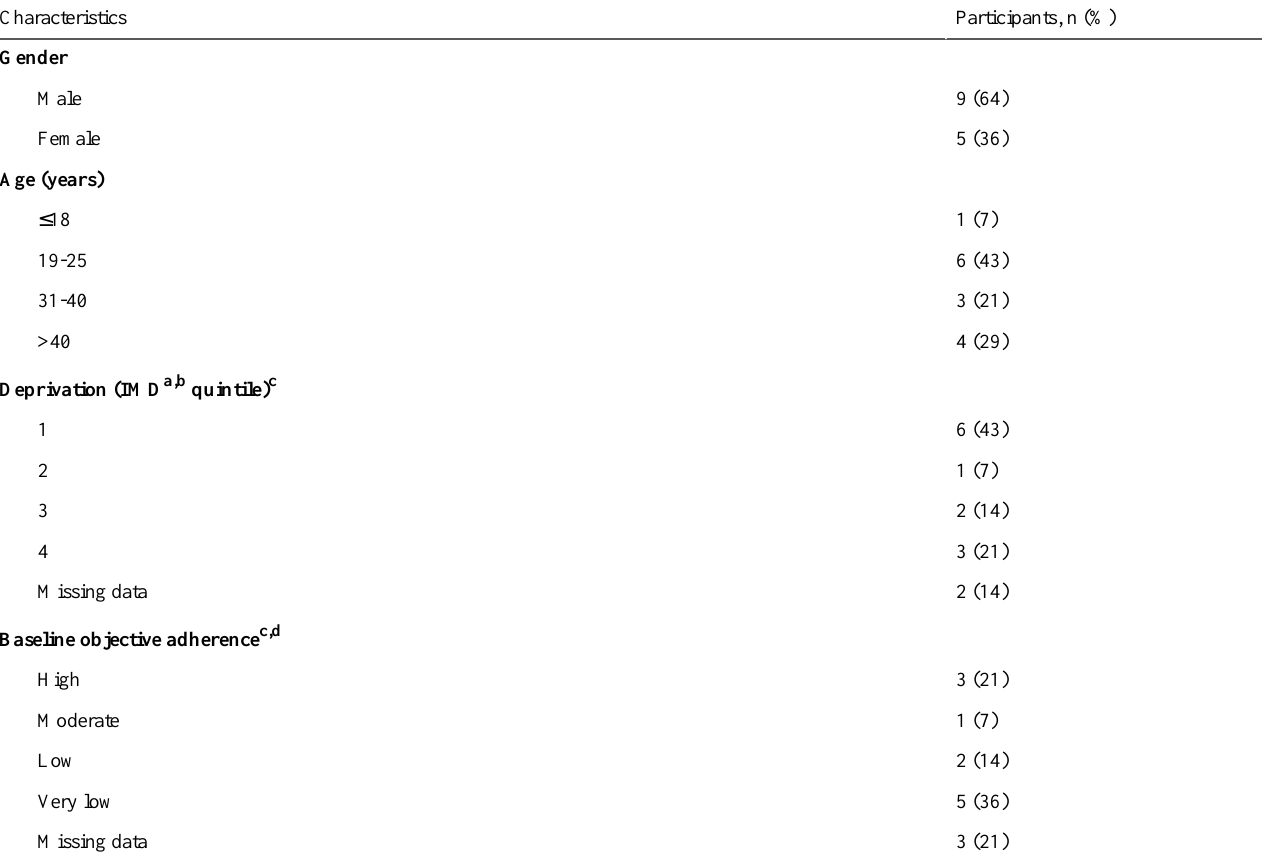
Table 2. Sociodemographic information for patient participants